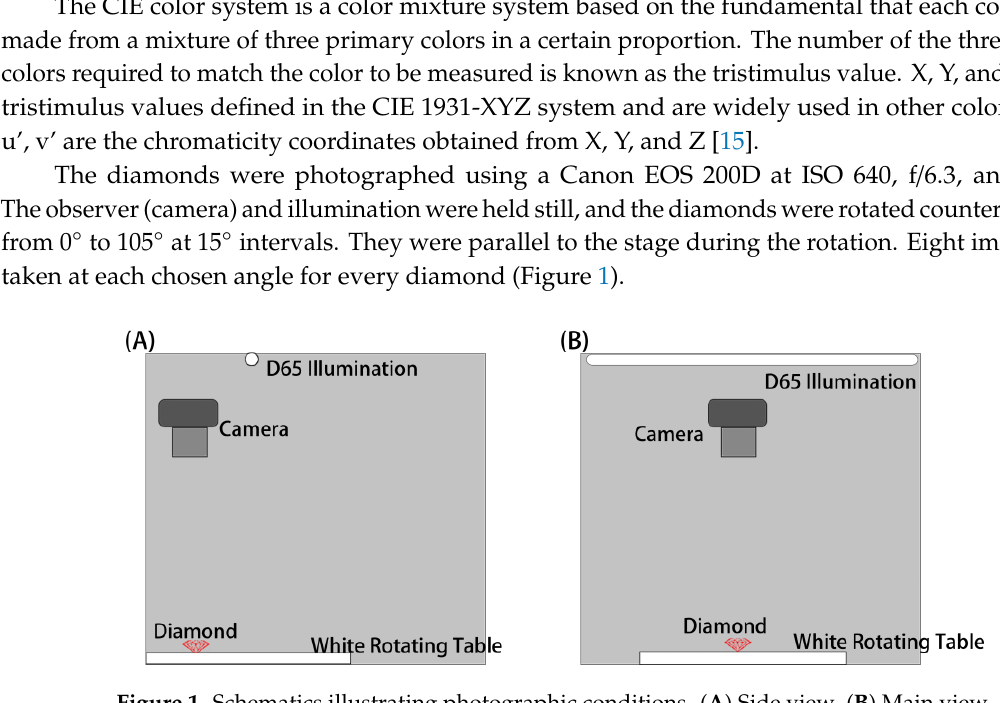
Figure 1. Schematics illustrating photographic conditions. ( A ) Side view. ( B ) Main view. Each diamond image was set to 500 × 500 pixels using Adobe Photoshop CC2018. In order to calculate the color difference between pixels of adjacent rotation angle images, and eight images of